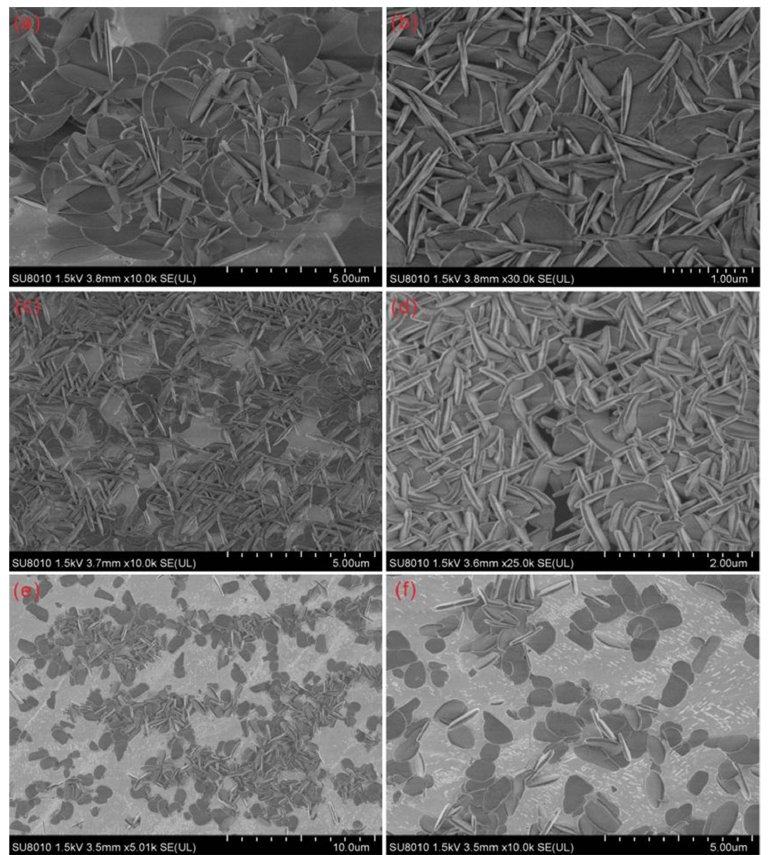
Figure 4. Representative SEM micrographs of zirconia micro-nanoflakes synthesized by 0.02 mol/L of the initial solution concentration: ( a ) No. 1 at 200 ◦ C, 100 MPa, and 12 h; ( b ) No. 3 at 250 ◦ C, 100 MPa, and 12 h; ( c ) No. 4 at 300 ◦ C, 120 MPa, and 12 h; ( d ) No. 5 at 400 ◦ C, 100 MPa, and 12 h; and ( e , f ) No. 8 at 500 ◦ C, 80 MPa, and 12 h.